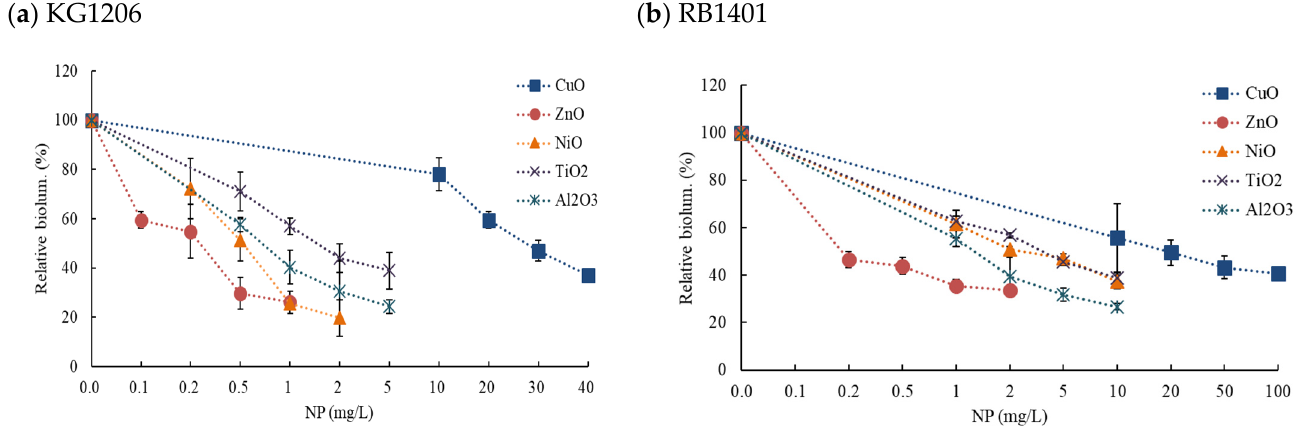
Figure 5. Comparisons of the changes of relative total bioluminescence with five individual NP (1 mM o -CT inducer): ( a ) KG1206; ( b ) RB1401 strains.